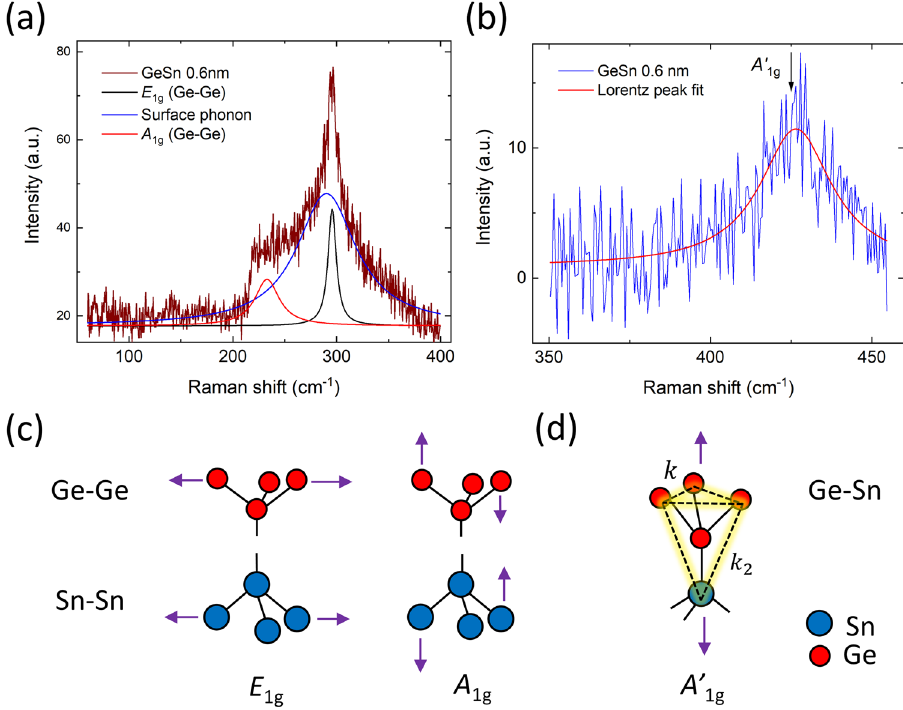
Fig. 6 Raman spectroscopy results for the GeSn bilayer. a The individual thickness of the Ge and Sn layers is estimated at ~0.3 nm. The Ge – Ge E 1g and A 1g modes are marked in black and red, respectively. The broad blue peak is attributed to surface phonons. b The A 0 bilayer can be well fi tted with a Lorentzian form (in red), showing that the peak is well de fi ned and has a narrow FWHM ≈ 25 cm − 1 . c A schematic representation of the E 1g and A 1g vibrational modes in the Ge – Ge and Sn-Sn layers. d The transverse Ge – Sn A 0